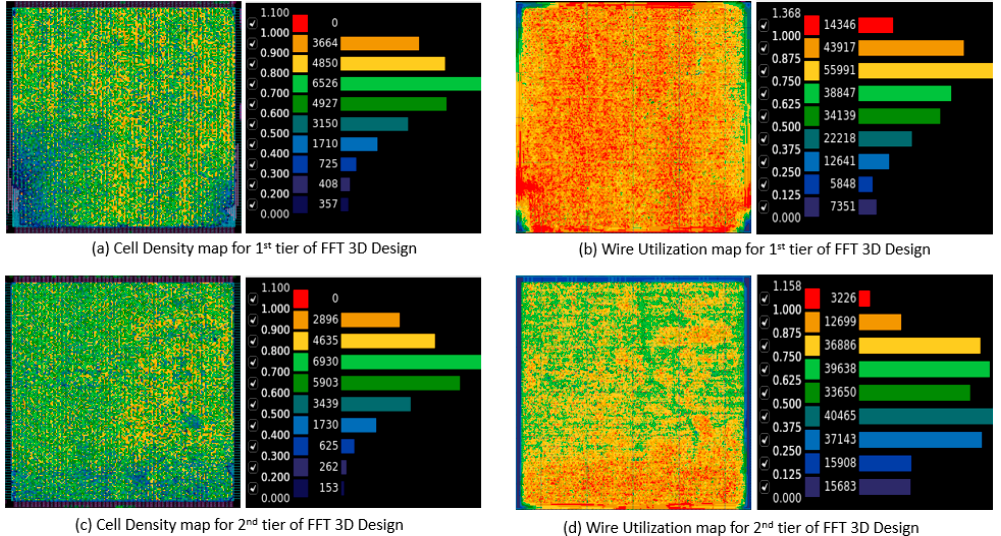
Figure 13. Cell density and wire utilization plots for two-tier FFT 3D designs using the AQ partitioner.